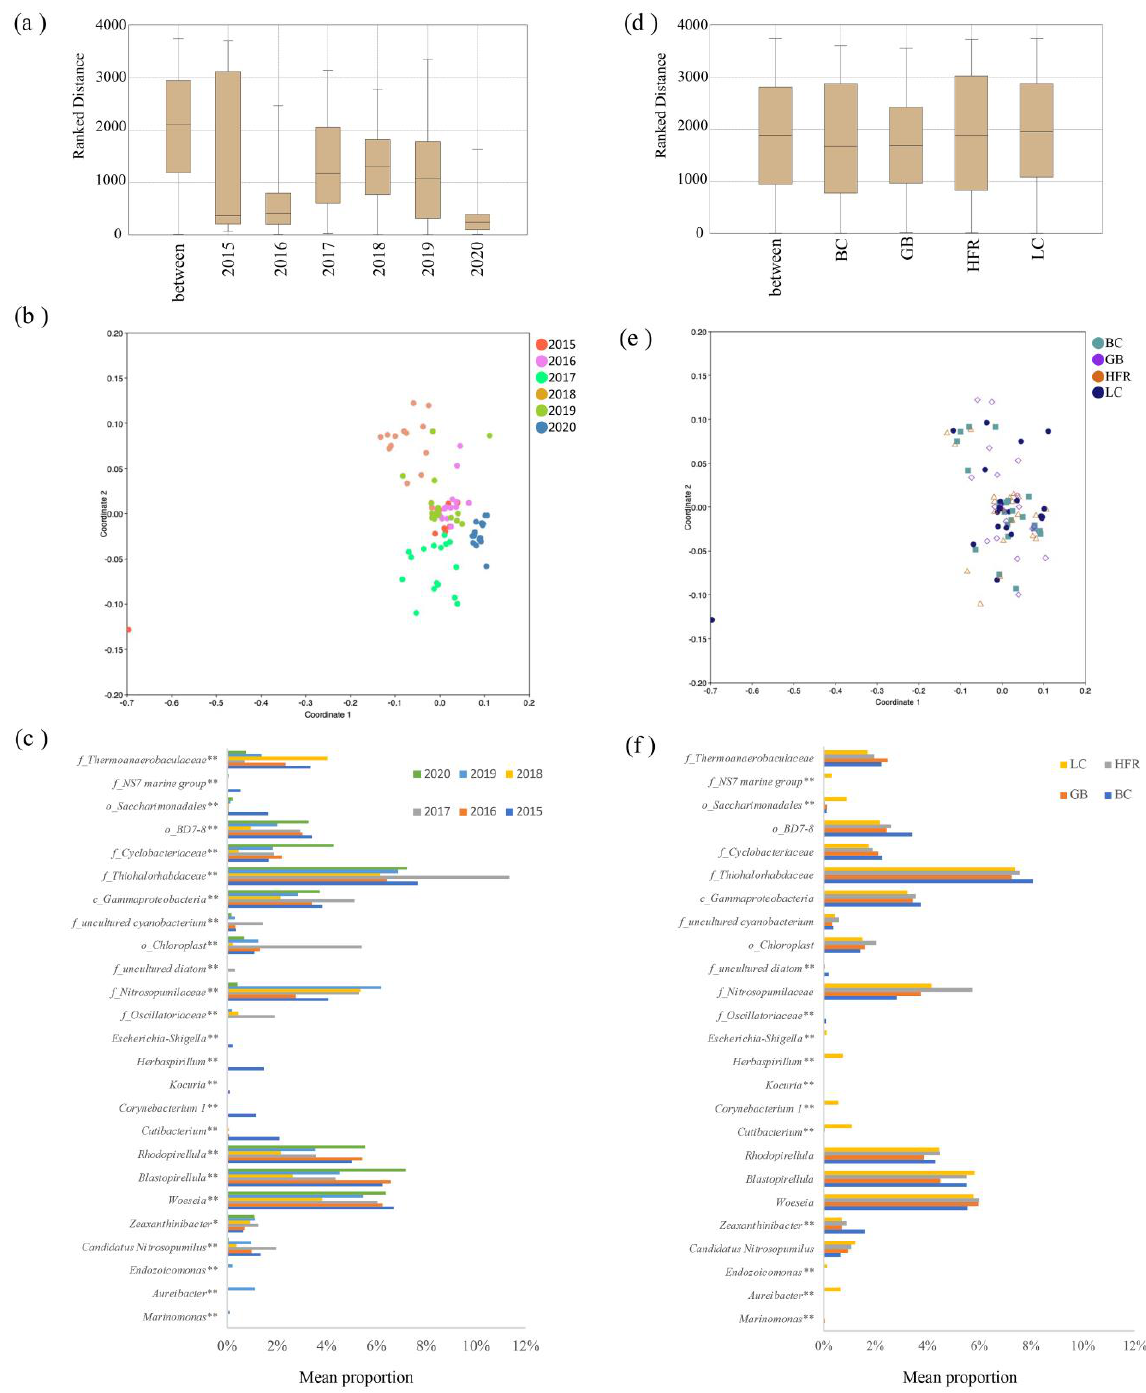
Figure 4. Differences in microbial communities among different years and locations. ( a , d ) show the similarities within and between years and locations, respectively. ANOSIM analysis based on Bray-Curtis distance of bacterial community structure at the genus level. ( b , e ) show that NMDS analysis based on Bray-Curtis distance of bacterial community structure at the genus level among all samples, ( b ) based on year and ( e ) based on location. ( c , f ) exhibit the differences in bacterial abundance across different years and locations, respectively. The differences were calculated using the likelihood ratio test in the CLC Microbial Genomics Module. The p -value was checked using FDR. * p < 0.05; ** p < 0.01. The BC, GB, HFR, and LC indicate the sites Beauty Cave, Geban Bay, Houshi Fringing Reef, and Lobster Cave,